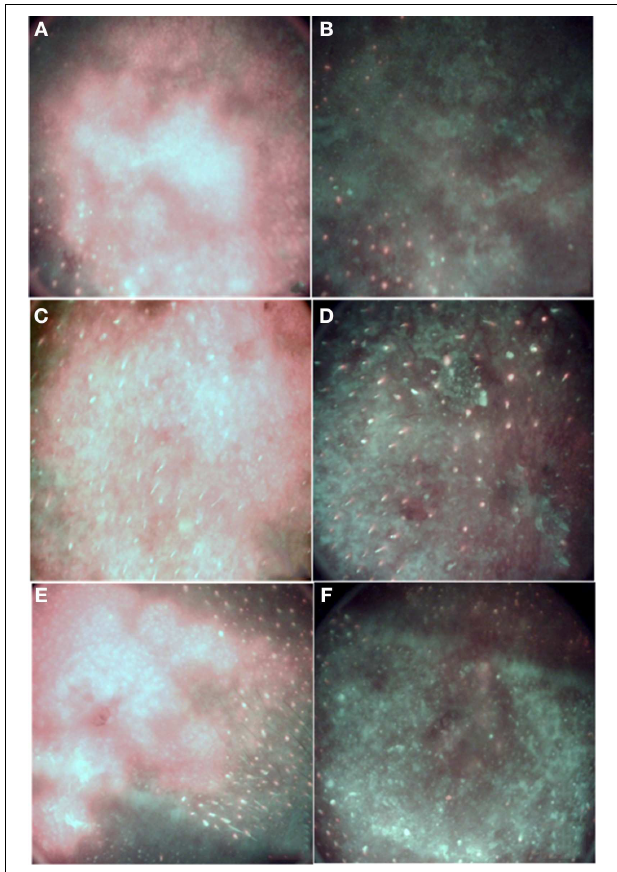
FIGURE 8 | PpIX fluorescence images of BCC lesions before 3h of MAL topical application (A,C,E) and after the second PDT session (B,D,F).